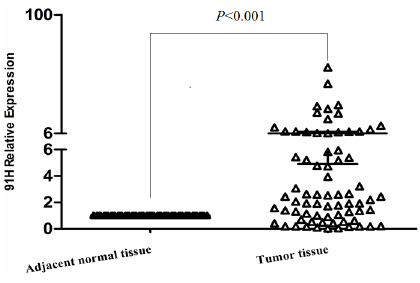
Figure 1. Comparison of 91H expression between tumor tissues and adjacent normal tissues from 72 patients